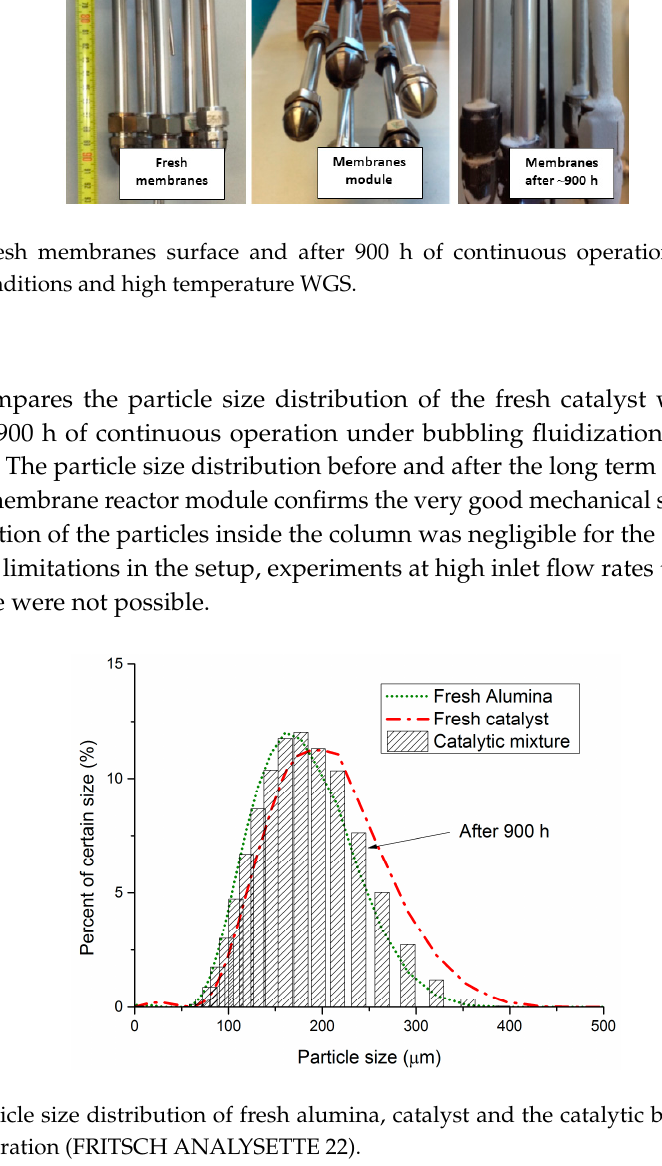
Figure 10. SEM images: ( a ) fresh membrane surface; ( b ) membrane surface after 900 h of continuous operation under bubbling fluidization conditions and WGS; and ( c ) membrane cross section.